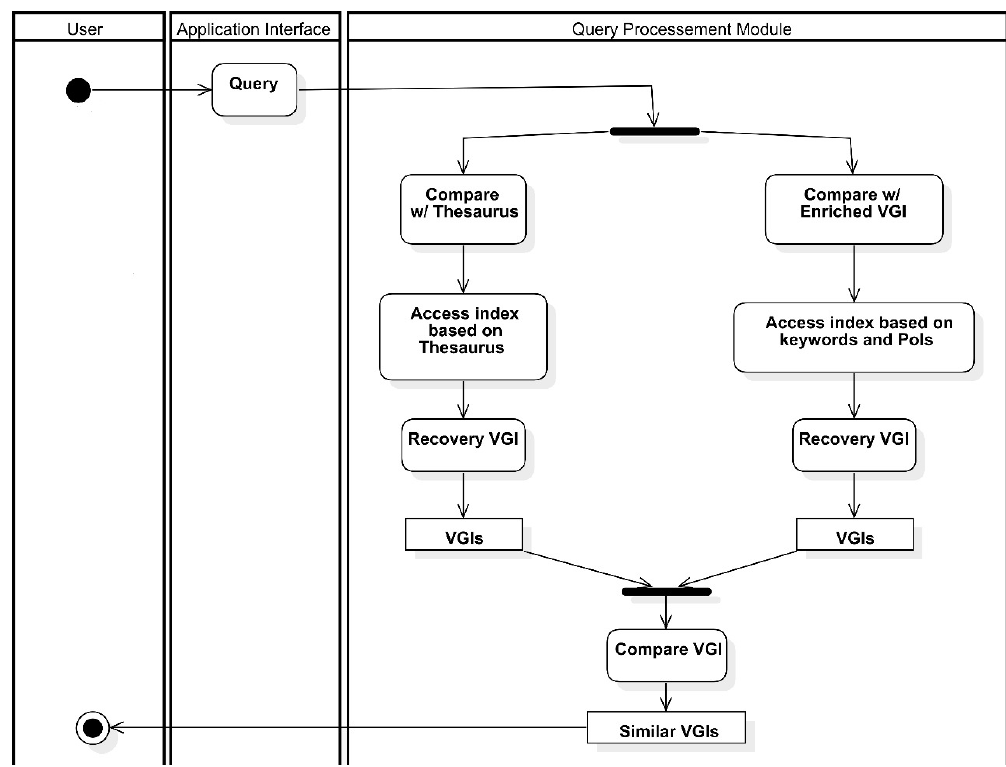
Figure 5. Process to return semantically similar VGI contributions based on a user-provided